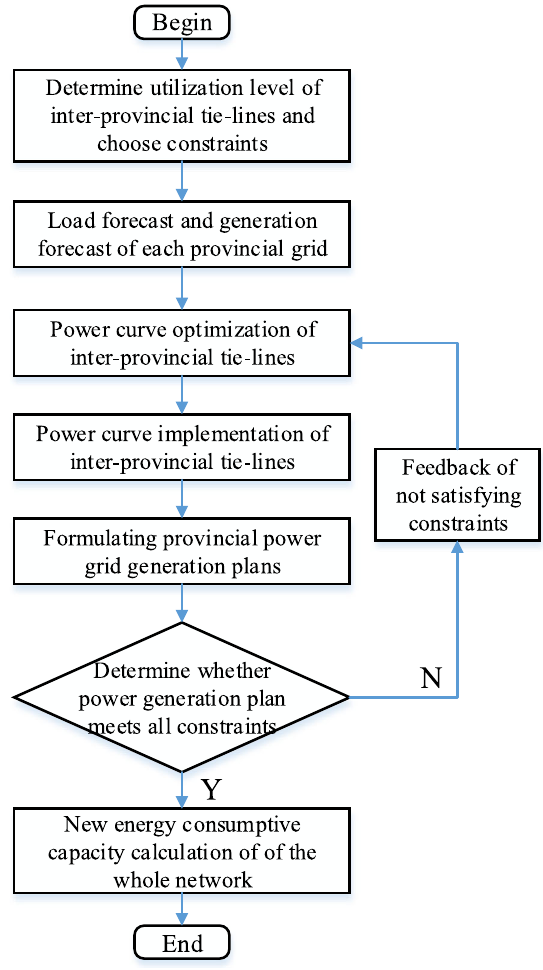
Fig. 2 Flow chart of renewable energy accommodation capacity